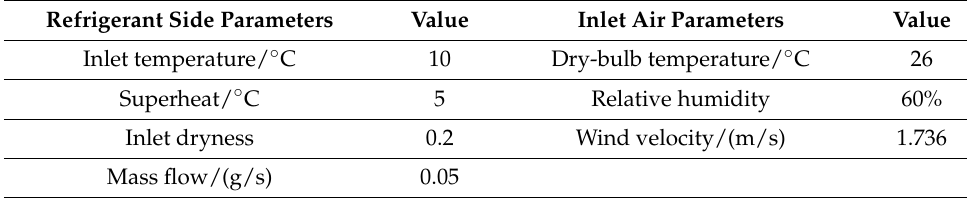
Table 2. Parameters of the inlet refrigerant and air microchannel heat exchanger.